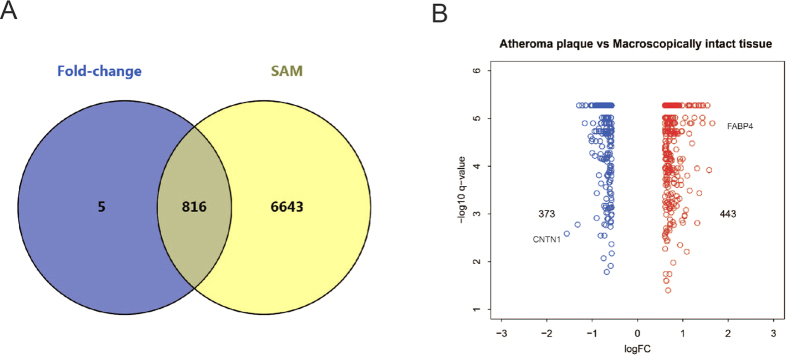
Differentially expressed genes were identified between ATH and MIT.(A) The overlapping gene set dually identified by the SAM and FC method. (B) Volcano plots for all differentially expressed genes in comparison. The dots indicate that up-(red) and down-regulated (blue) DEGs were significant both at false-discovery rate <0.05 and Fold-change >1.5 or <0.667.